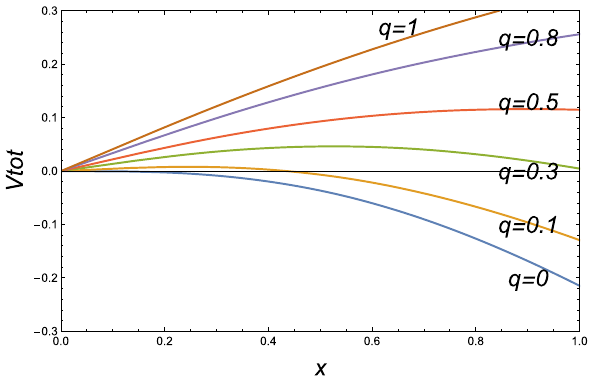
Fig. 5 The relation of V tot ( x ) and q in the D(-1)–D3 background with b = 0 . 5 3 / 2 , ˜ α =